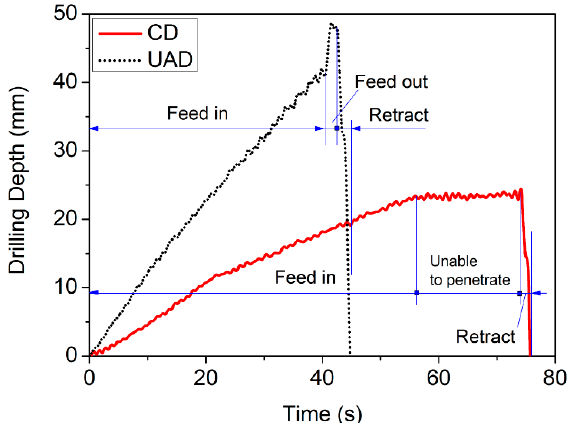
Figure 4. Time histories of the hole depth obtained with conventional drilling (CD) (red solid line) and UAD (black dot) when an axial force of 6 kgf was applied.